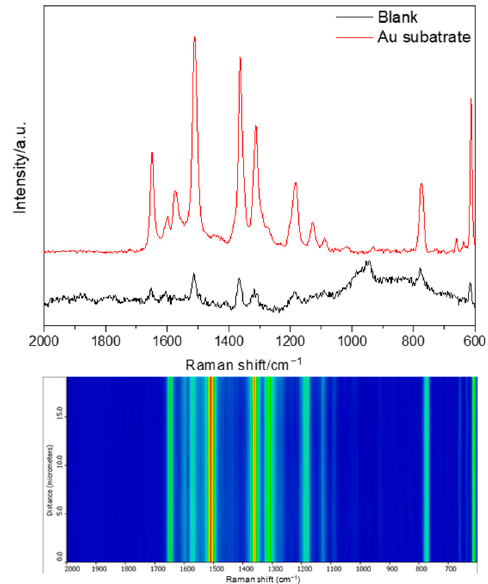
Figure 6. ( Upper ): Raman spectrum (Blank) of 1 × 10 − 5 M R6G and SERS spectrum (excited at 633 nm) of 1 × 10 − 5 M R6G on the Au NPs substrate. ( Lower ): SERS contour from line mapping of 5 spots.